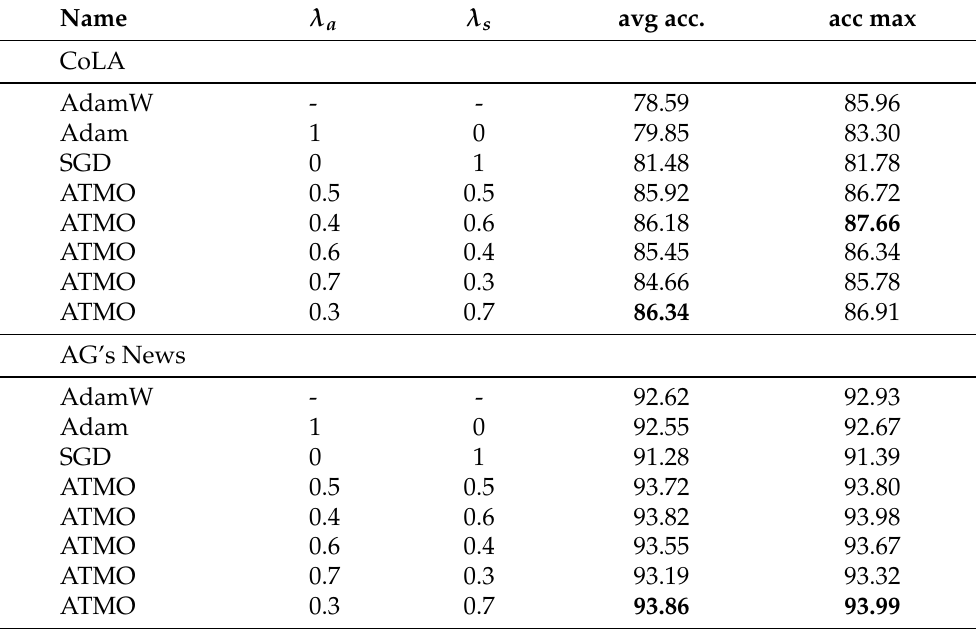
Table 4. Accuracy results of BERT pre-trained on CoLA (50 epochs) and AG’s news (10 epochs) after 5